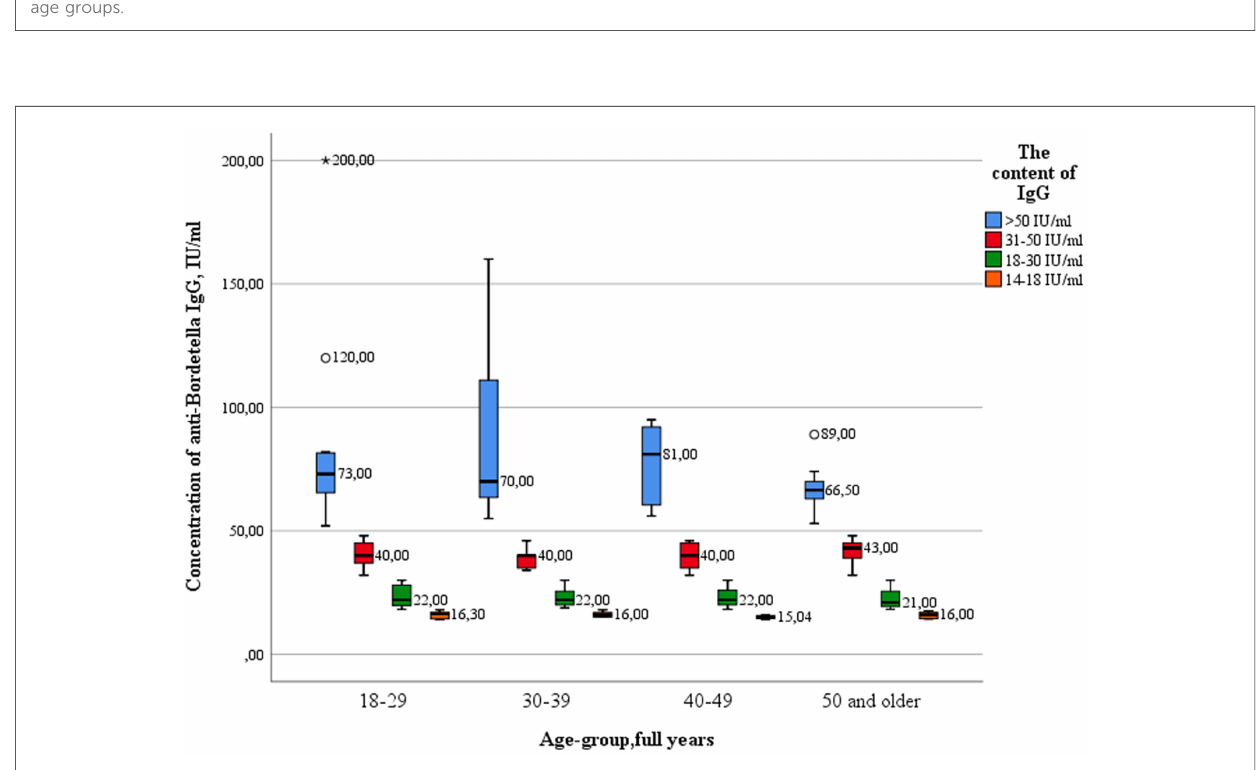
FIGURE 7 The level of pertussis immunity in different age groups of healthcare